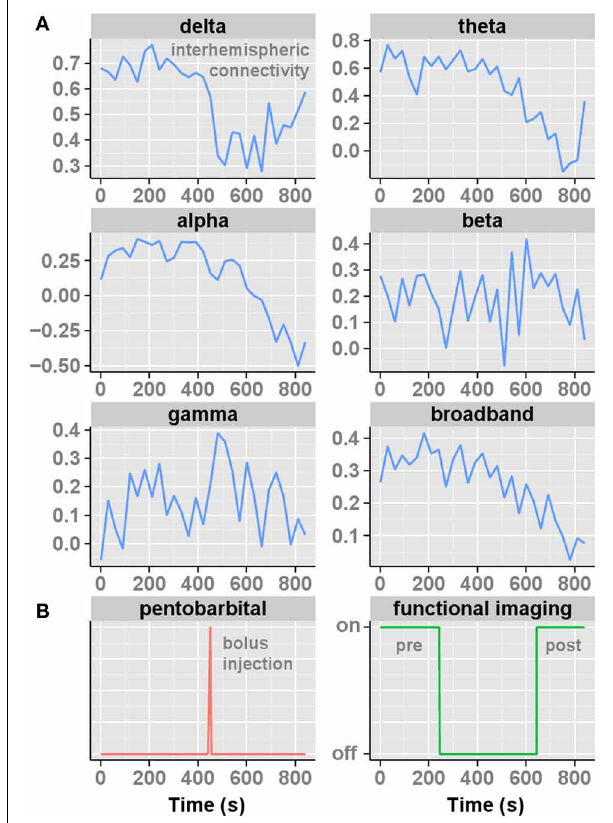
FIGURE 5 | The interhemispheric somatosensory functional EEG connectivities (measured as correlation coefficients ( r )) for consecutive epochs, each 30s, plotted over time (15min) for the distinct frequency bands (A). The corresponding moment of pentobarbital injection and periods of resting-state fMRI used to construct functional networks are shown below (B) . Note that functional imaging was acquired prior to EEG, but was identical in approach and timing of pentobarbital